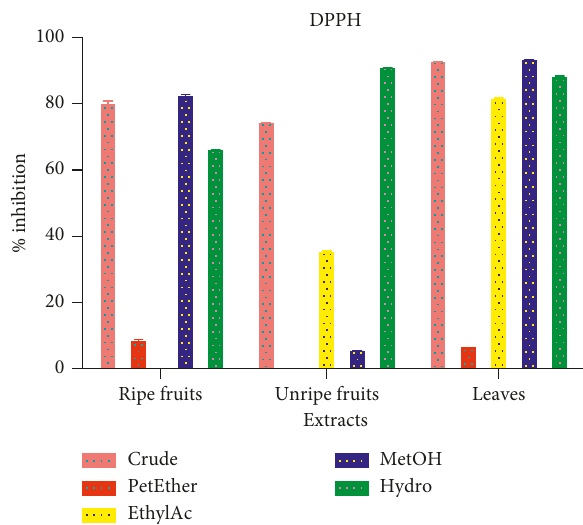
Figure 7: The DPPH free radical scavenging activity of D. erecta